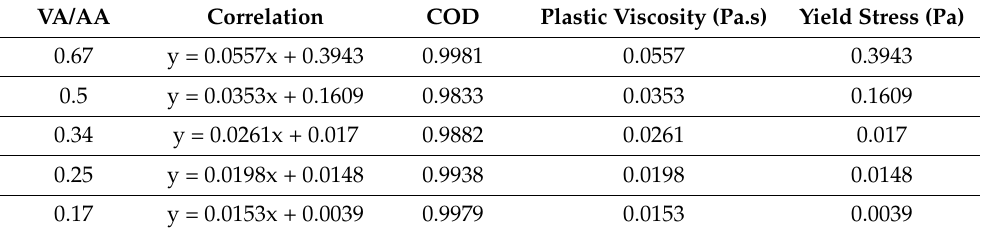
Table 4. Rheological parameters of geopolymeric pastes with different binder-to-activator ratios.